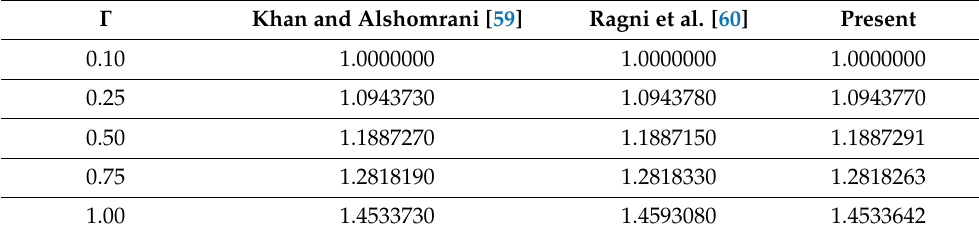
Table 1. A comparison of skin friction − Re 1 2 C f .